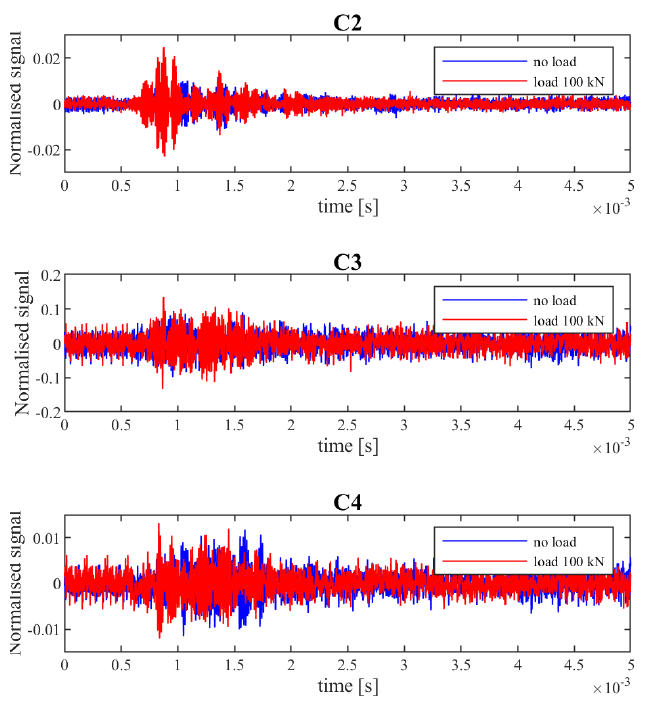
Figure 7. Examples of registered signals after the alarm state and with and without loading.